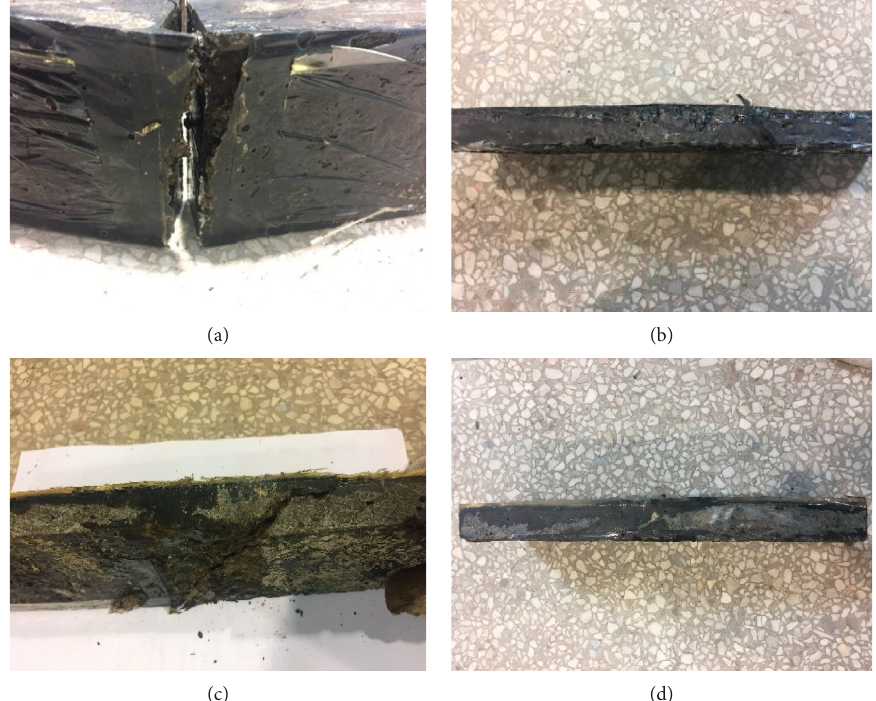
Figure 19: Fatigue cracking behaviors of the specimens of resin composite overlays reinforced with different fibers at 75 ° C. (a) Blank. (b) BF- reinforced beam. (c) GF-reinforced beam. (d) CF-reinforced